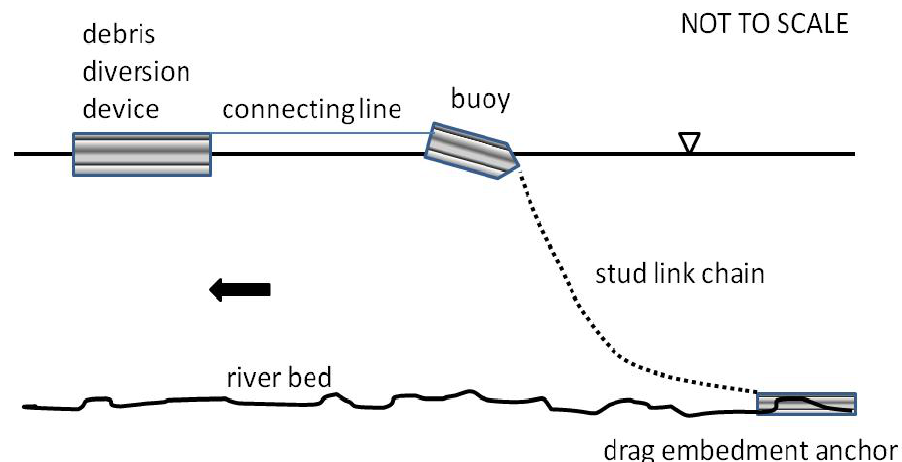
Figure 1. Sketch of the field